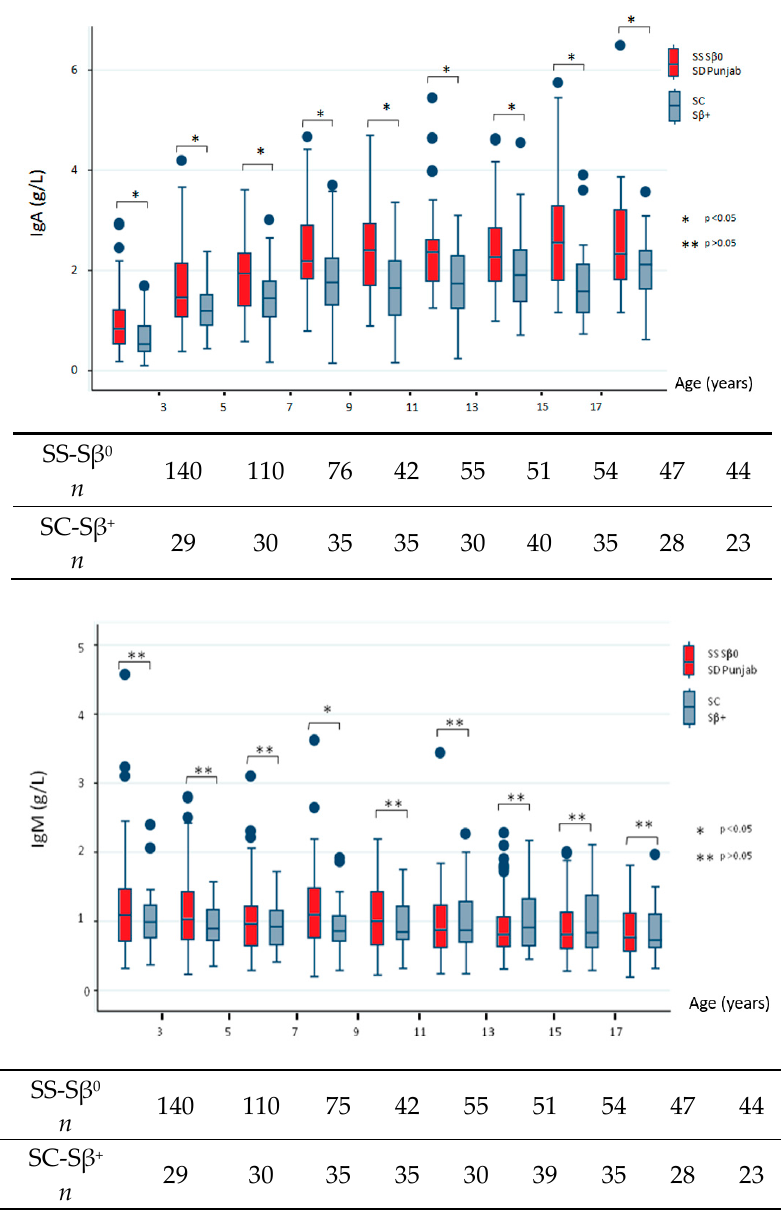
Figure 1. Immunoglobulin (Ig)G, IgA, and IgM levels by age group. Only values collected before any therapeutic intensification and / or splenectomy were analyzed and compared between children with severe sickle genotypes (HbSS, HbS β 0 , and HbSD Punjab) and milder genotypes (HbSC and HbS β +